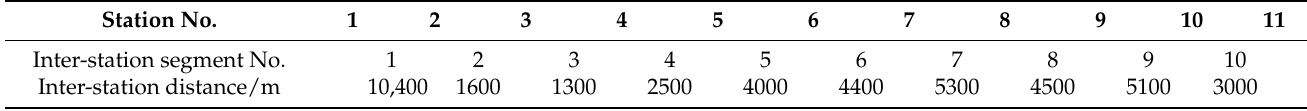
Figure 6. Stations on the Jiangjin Line. Table 2. Inter-station distances on the Jiangjin Line.